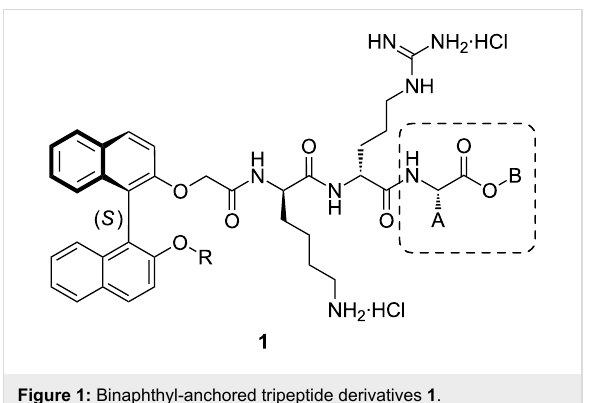
Figure 1: Binaphthyl-anchored tripeptide derivatives 1